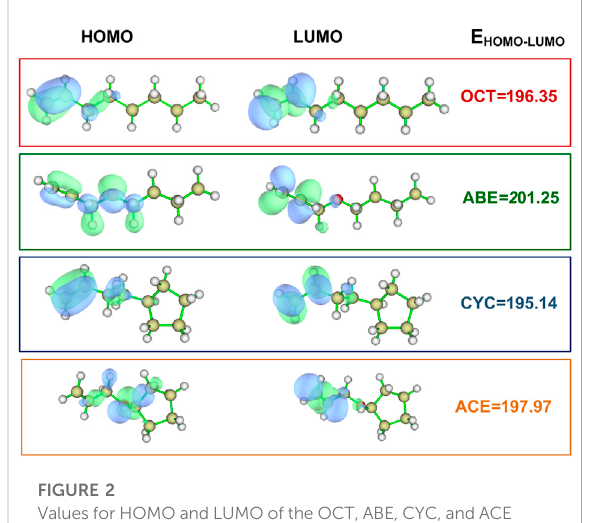
FIGURE 2 Values for HOMO and LUMO of the OCT, ABE, CYC, and ACE at the M06-2X/6-311++g(d,p) level (Unit: kcal/mol).